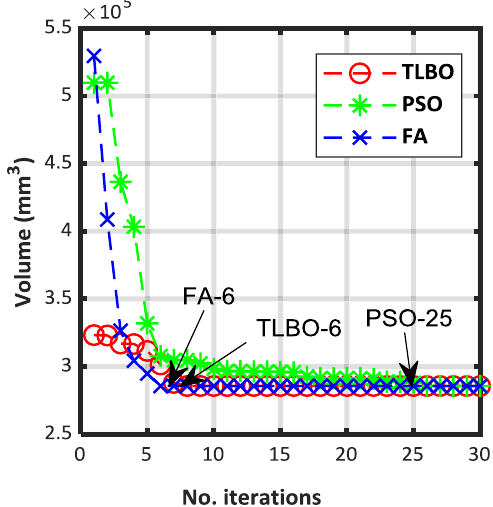
Fig. 10. Hole-pro fi le convergence results.